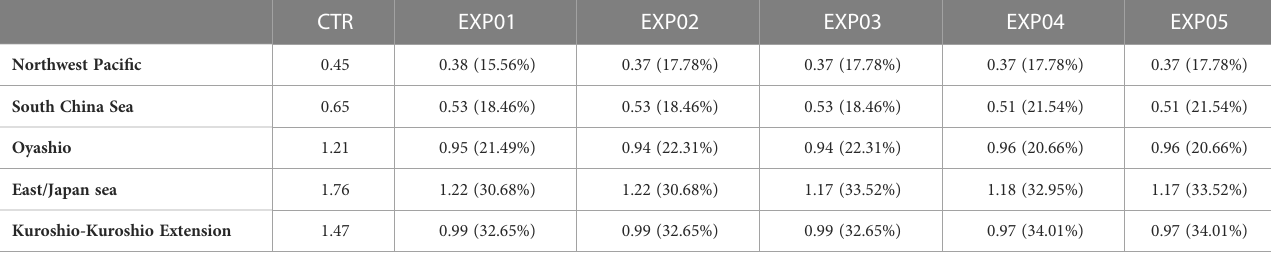
TABLE 2 Root-mean-square error (RMSE) averaged in space and time for SST by region from all experiments. CTR EXP01 EXP02